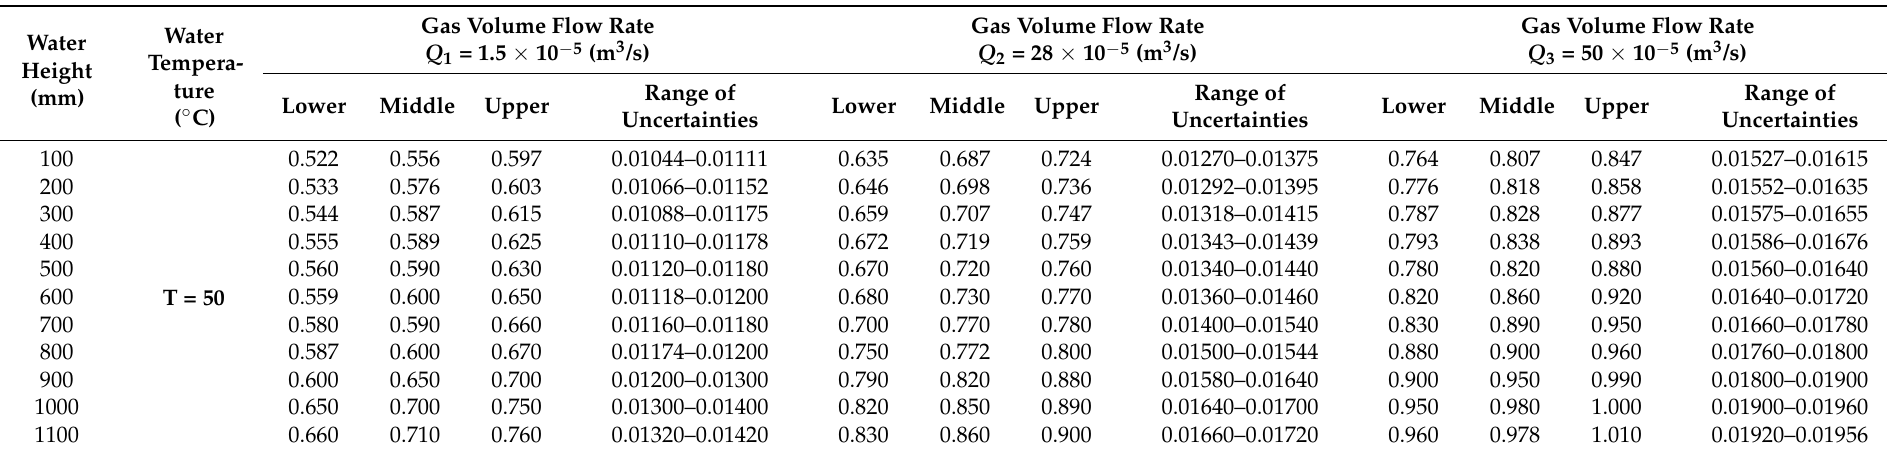
Table 9. Bubble speed (m/s) as a function of water height for T = 50 ◦ C and for gas volume flow rates Q 1 –Q 3